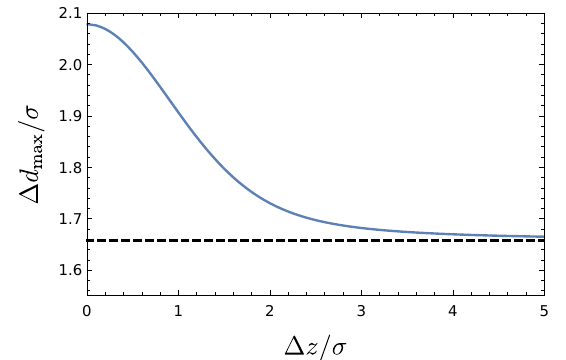
Figure 4. The maximum harvesting-achievable separation, ∆ d max , between two detectors is plot- ted as a function of the distance between detectors and the boundary with Ω σ = 0 . 10 . The dished line indicates the case of a free space without any